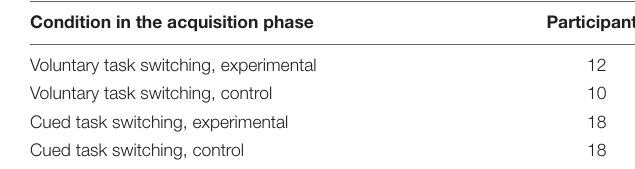
TABLE 2 | Distribution of participants in Experiment 2 in each condition after